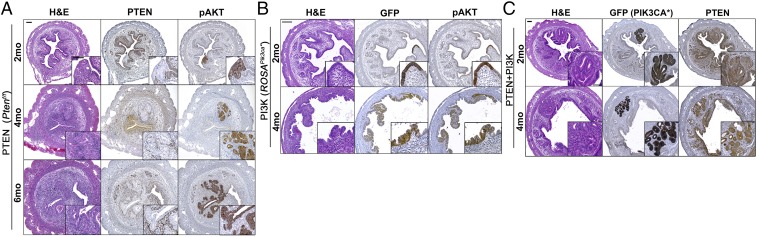
Histopathological analyses of the uteri with PTEN LOF and/or PI3K GOF mutation. Biallelic loss of Pten (A), GOF mutation of PI3K (B), and the combination of loss of Pten and PI3K GOF (C) followed up to 6 mo. Insets (IHC): Epithelial lesions were highlighted by loss of PTEN proteins (A), Cre activation (GFP) (B and C), and phosphorylation of AKT (A–C). (Scale bars: 100 μm.)